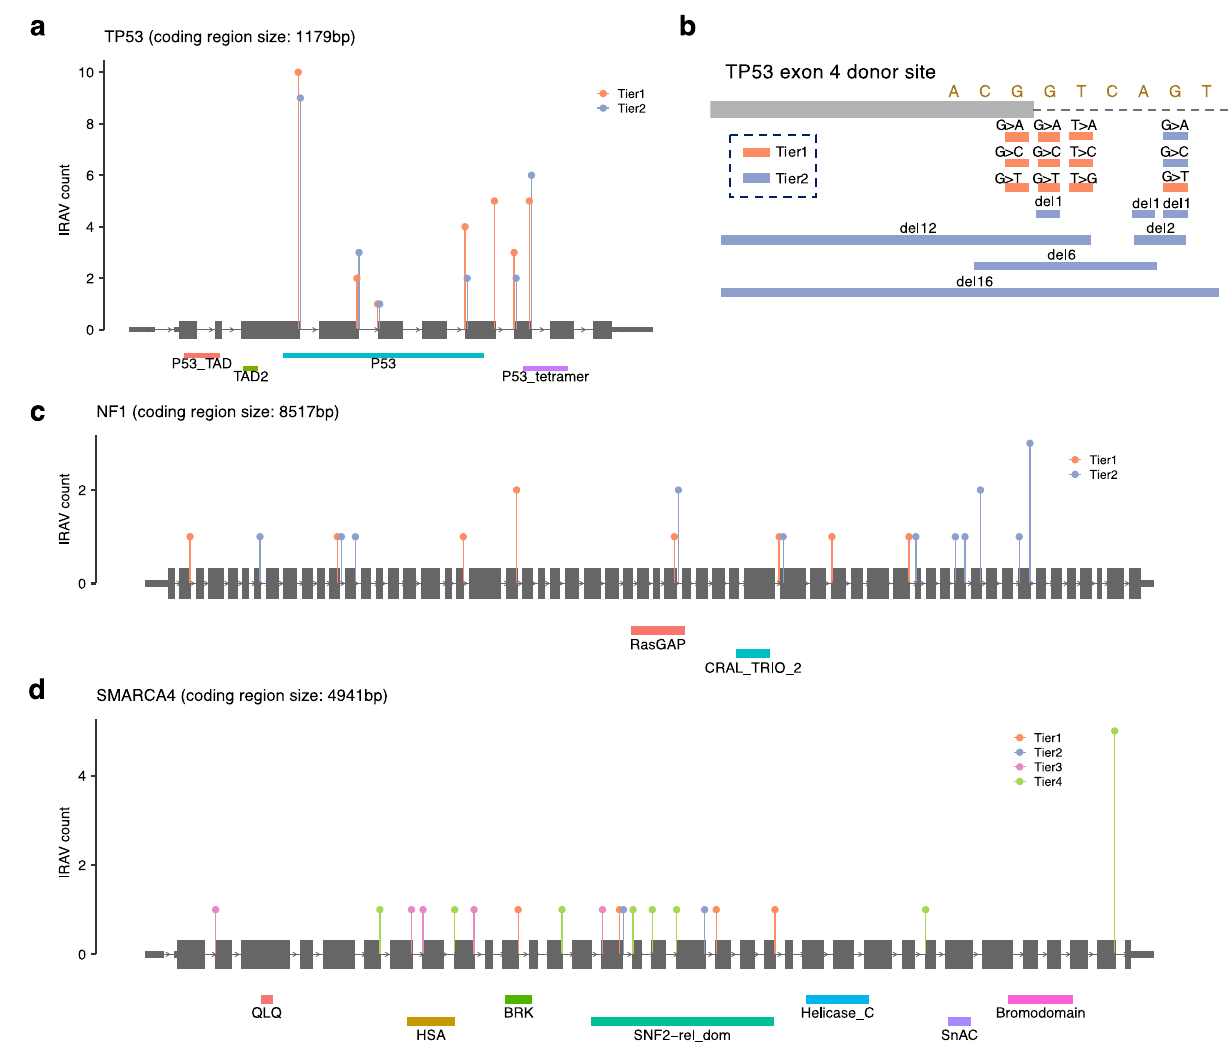
Fig.5|DistributionofIRAVsingeneswithfrequentIRAVs.a , c , d Frequenciesof putative pathogenicIRAVs foreachpathogenictier ateach splice-site areshown in a TP53 , c NF1 ,and d SMARCA4 . b ThecatalogofIRAVsatthe TP53 exon4donorsite